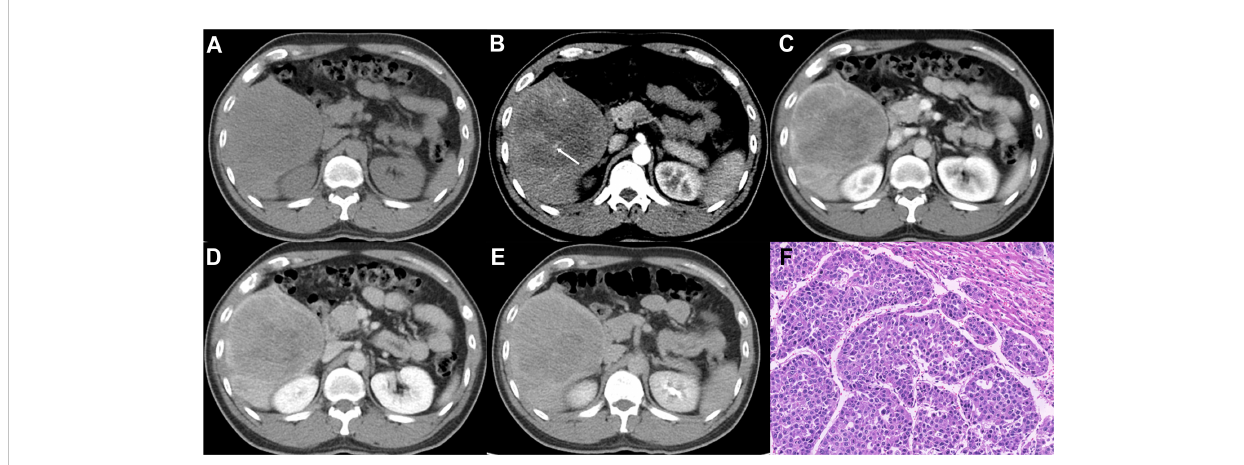
FIGURE 2 Imaging features and pathological information of a 37-year-old male MTM-HCC patient with an AFP level of 245,658 ng/mL and hemoglobin of 176 g/L. Multiphase axial contrast-enhanced CT (CECT) displays low attenuation in the unenhanced phase (A) , the intratumor artery (white arrow) in the early arterial phase (B) , rim hyperenhancement (APHE) and intratumor hypoenhancement in the late arterial phase (C) , portal venous phase (D) , and delay phase (E) . Histopathology revealed the predominant thick trabecular structure diagnosed as MTM-HCC ( F , original magni fi cation, × 100; hematoxylin-eosin staining).